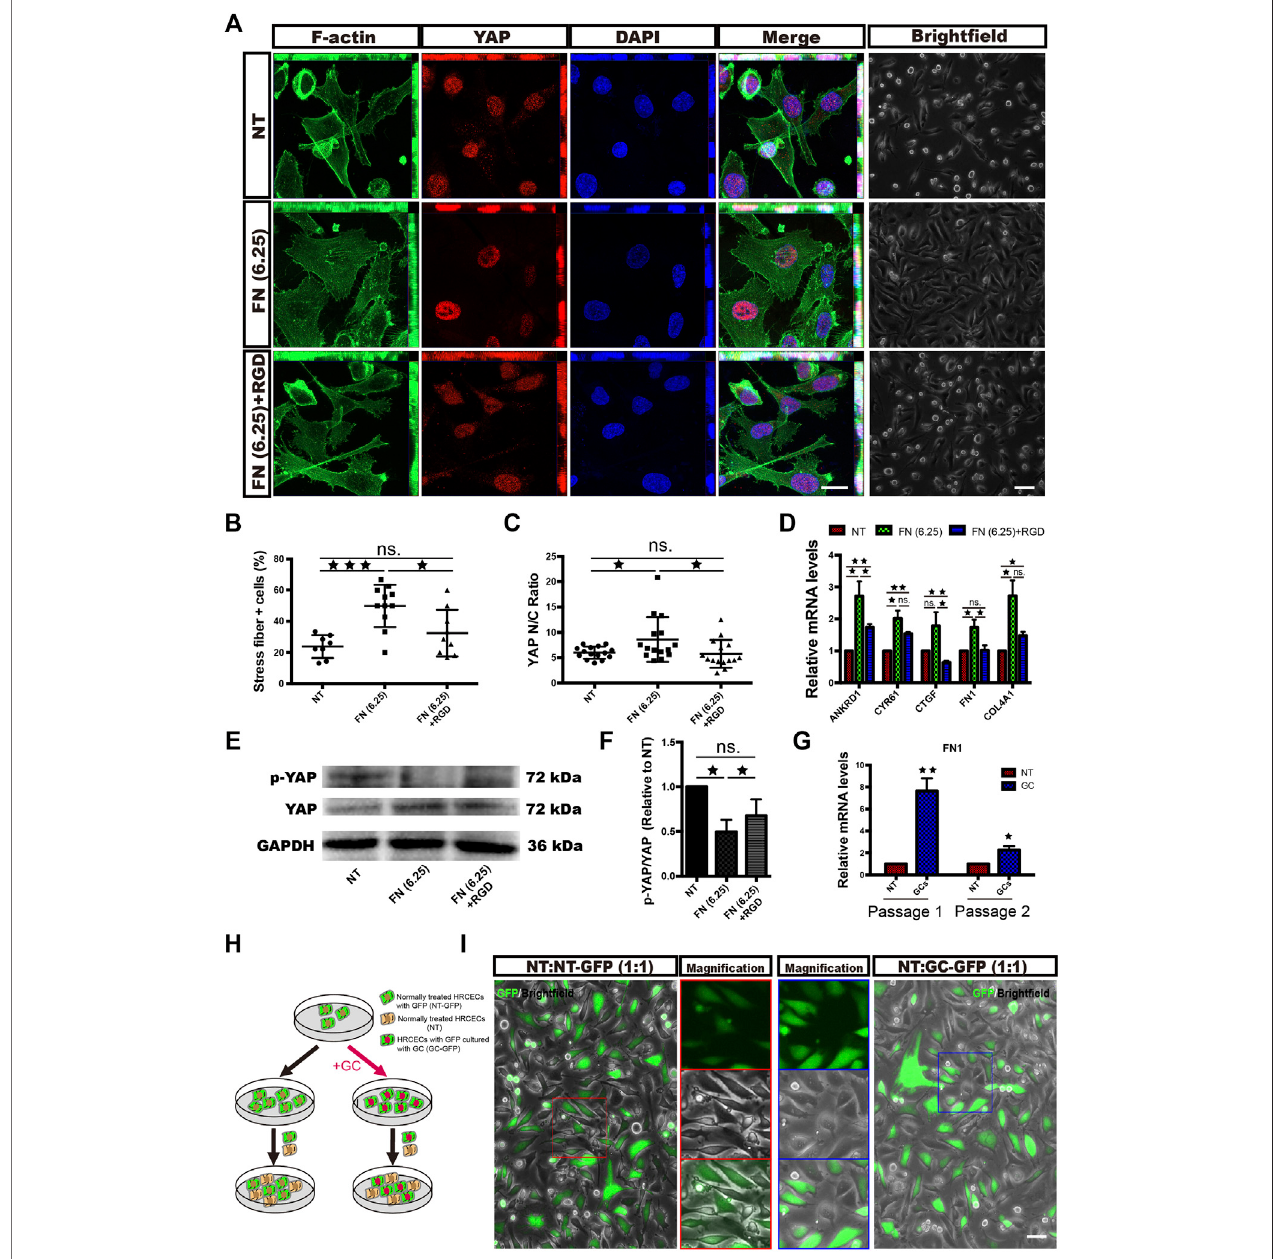
FIGURE5| FNpartiallypromotesstress fi berformation,YAPnucleartranslocationandmorphologicalchangesinHRCECsviaECM-integrinsignaling. (A) :F-actin/ YAP/DAPIstainingwasperformedbyimmuno fl uorescenceinHRCECsculturedinRPMI1640Medium(Gibco)containing10%FBS(Gibco)aloneorincombinationwith 1 mg/ml RGD on dishes coated with 6.25 μ g/cm 2 FN for 72 h. Scale bars, 20 μ m. Bright fi eld microscopy images of HRCECs treated under the indicated condition. Scalebars,100 μ m. (B) :Quanti fi cationofthepercentageofcellsdisplayingactinstress fi bersforthethreetreatmentconditionsin (A) . (C) :Quanti fi cationoftheratio oftheaverageimmuno fl uorescenceintensityofYAPbetweenthenucleusandthecytoplasmofthecellsin (A) . (D) :Real-timeqPCRanalysisofHRCECstreatedasin (A) . The mRNA levels of YAP1 and ANKRD1/CYR61/CTGF (targets of YAP) were calculated. (E) : WB analysis of YAP and p-YAP of HRCECs treated as in (A) . p-YAP is phospho-S127. (F) : The p-YAP/YAP in (E) is quanti fi ed and normalized to NT group. (G) : Real-time qPCR analysis of passage-1 and passage-2 HRCECs. Passage-1 HRCECs were cultured in RPMI 1640 medium (Gibco) containing 10% FBS (Gibco) alone (NT) or in combination with 0.8 μ M hydrocortisone (GC) for 72 h. Passage-2 HRCECs were derived from passage-1 cells. (H) : Flow chart of cell coculture. HRCECs with GFP were divided into two groups: one group was pretreated with hydrocortisoneandcoculturedwithnormalHRCECsataratioof1:1[theNT:GC-GFP(1:1)group],andtheotherwasdirectlycoculturedwithnormalcellsataratioof1:1 [the NT:NT-GFP (1:1) group]. (I) : Representative GFP fl uorescence and bright fi eld images. Scale bars, 100 μ m. The error bars represent the mean ± SD, and the experiment was biologically repeated three times. * p < 0.05; ** p < 0.01; *** p < 0.001, ns., not signi fi cant. Student ’ s two-tailed paired t-test (D,F,G) or Student ’ s two- tailed unpaired t-test (B,C) . GFP green fl uorescent protein, RGD Arg-Gly-Asp.